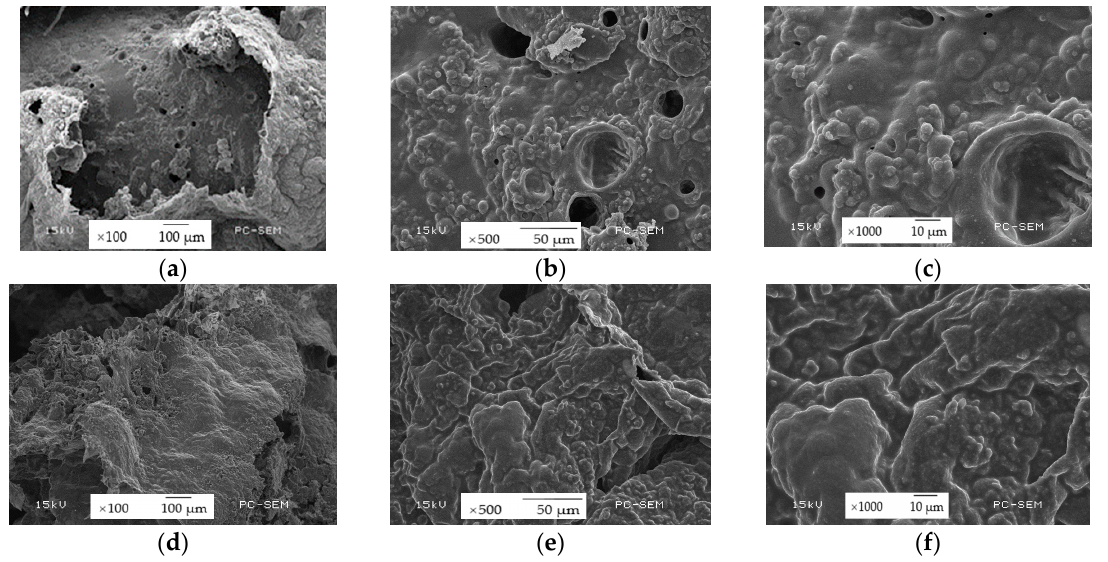
Figure 6. SEM micrographs of residues of PLA-8 ( a ×100, b ×500, c ×1000) and PLA-6 ( d ×100, e ×500, f ×1000) after cone calorimeter testing.